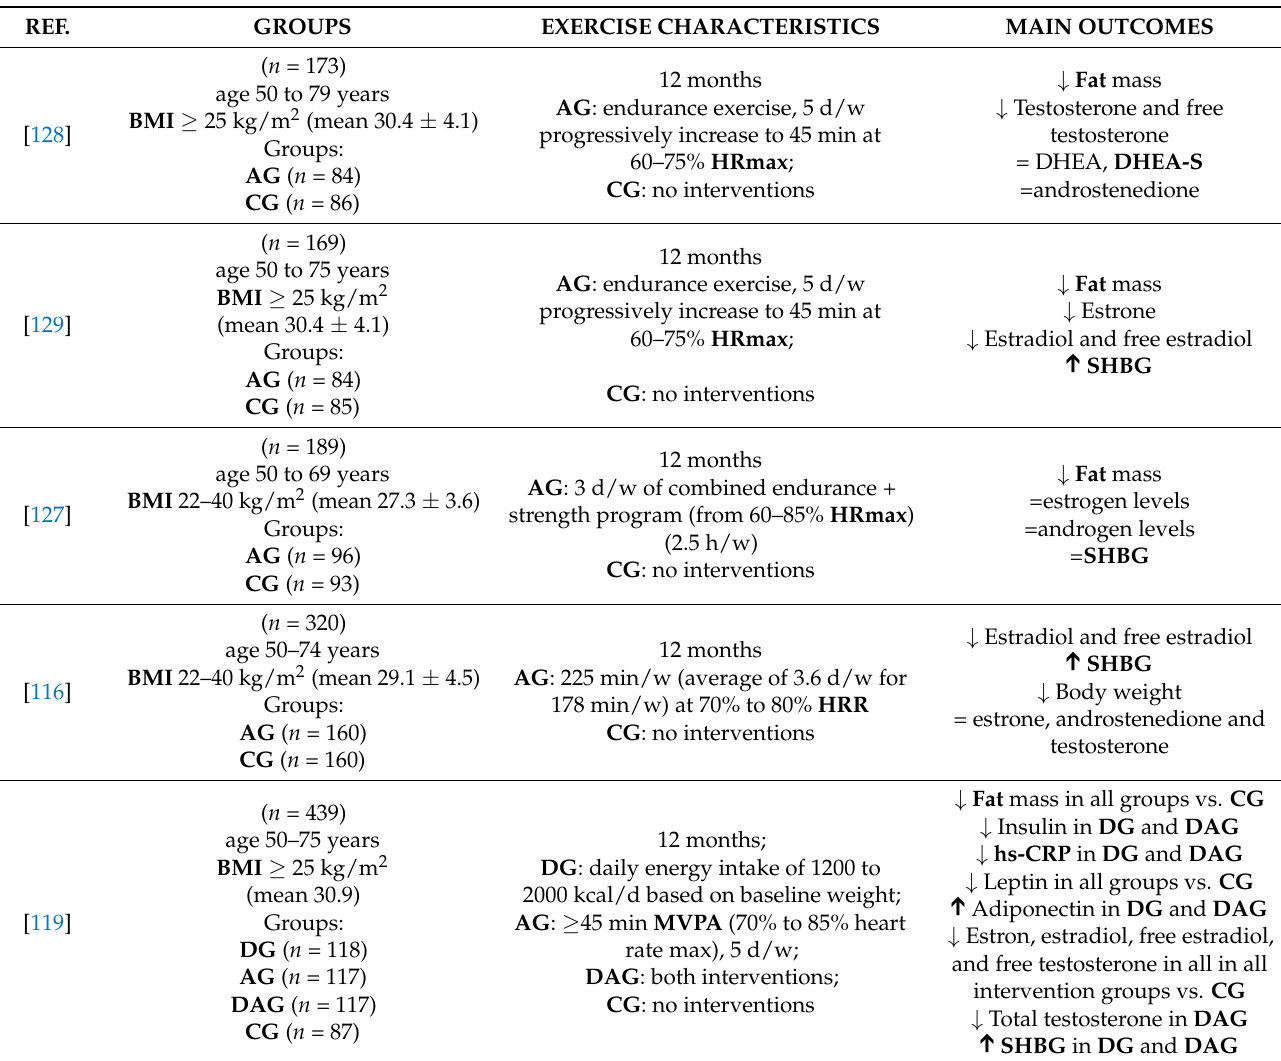
Table 2. Exercise and physical activity in primary prevention of breast cancer in overweight/obese postmenopausal women.